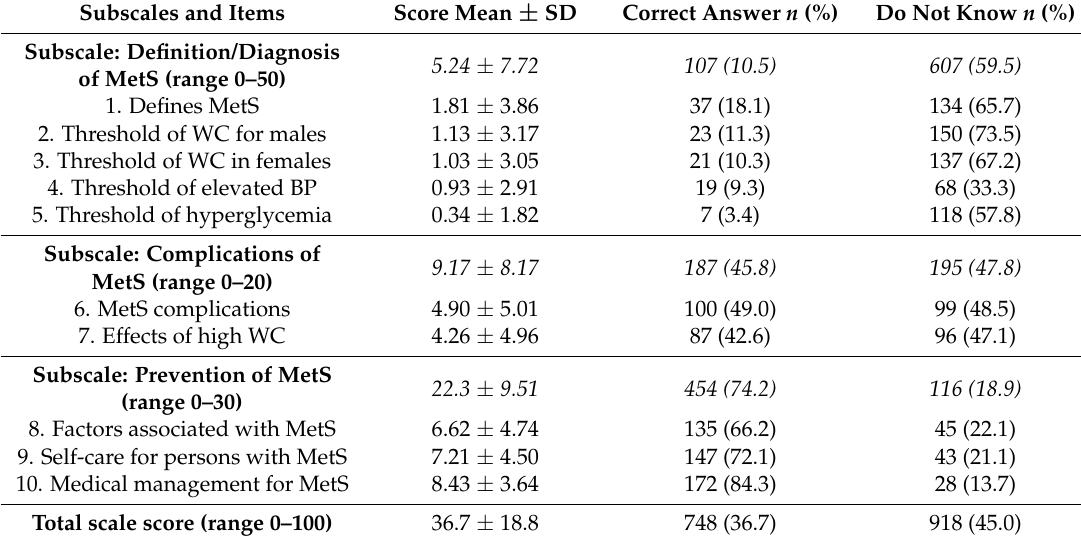
Table 3. Metabolic Syndrome Knowledge Scale Scores (n =